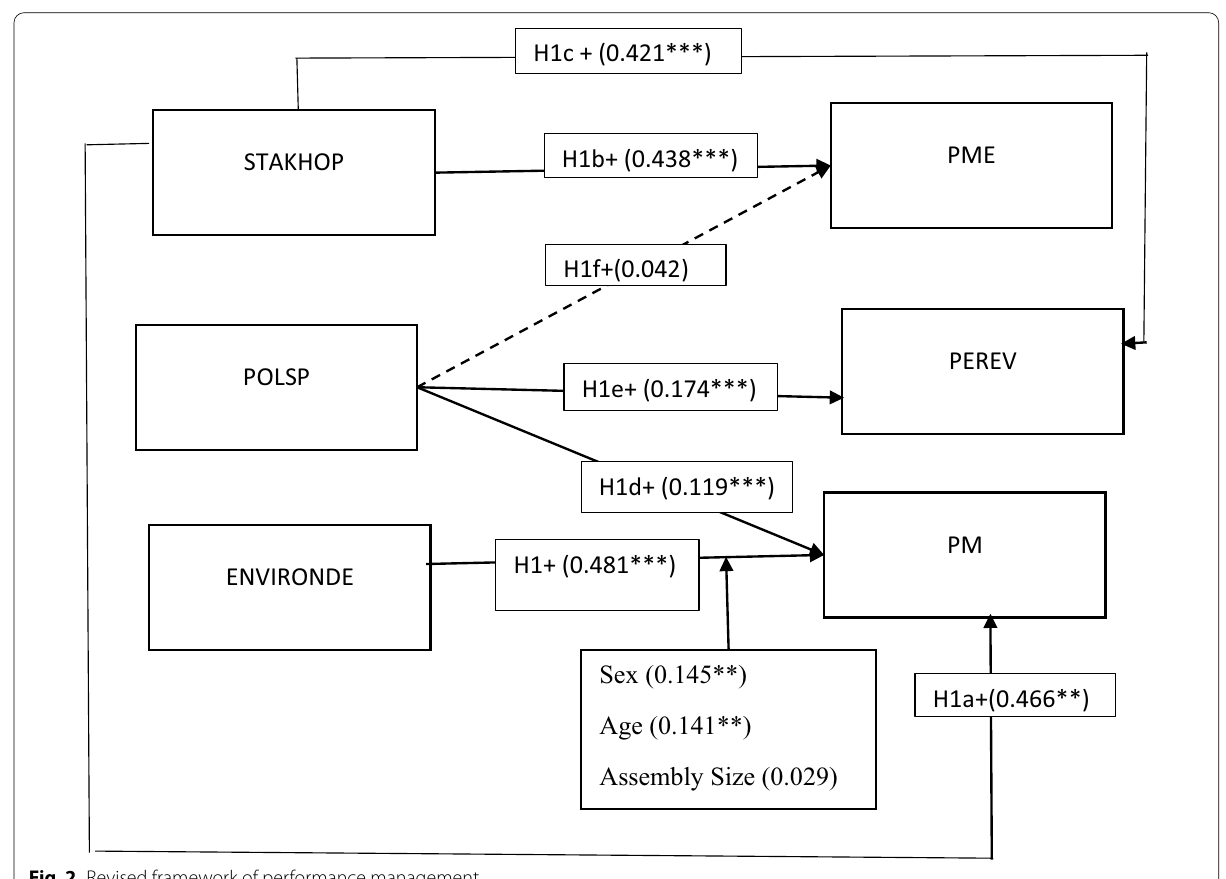
Fig. 2 Revised framework of performance